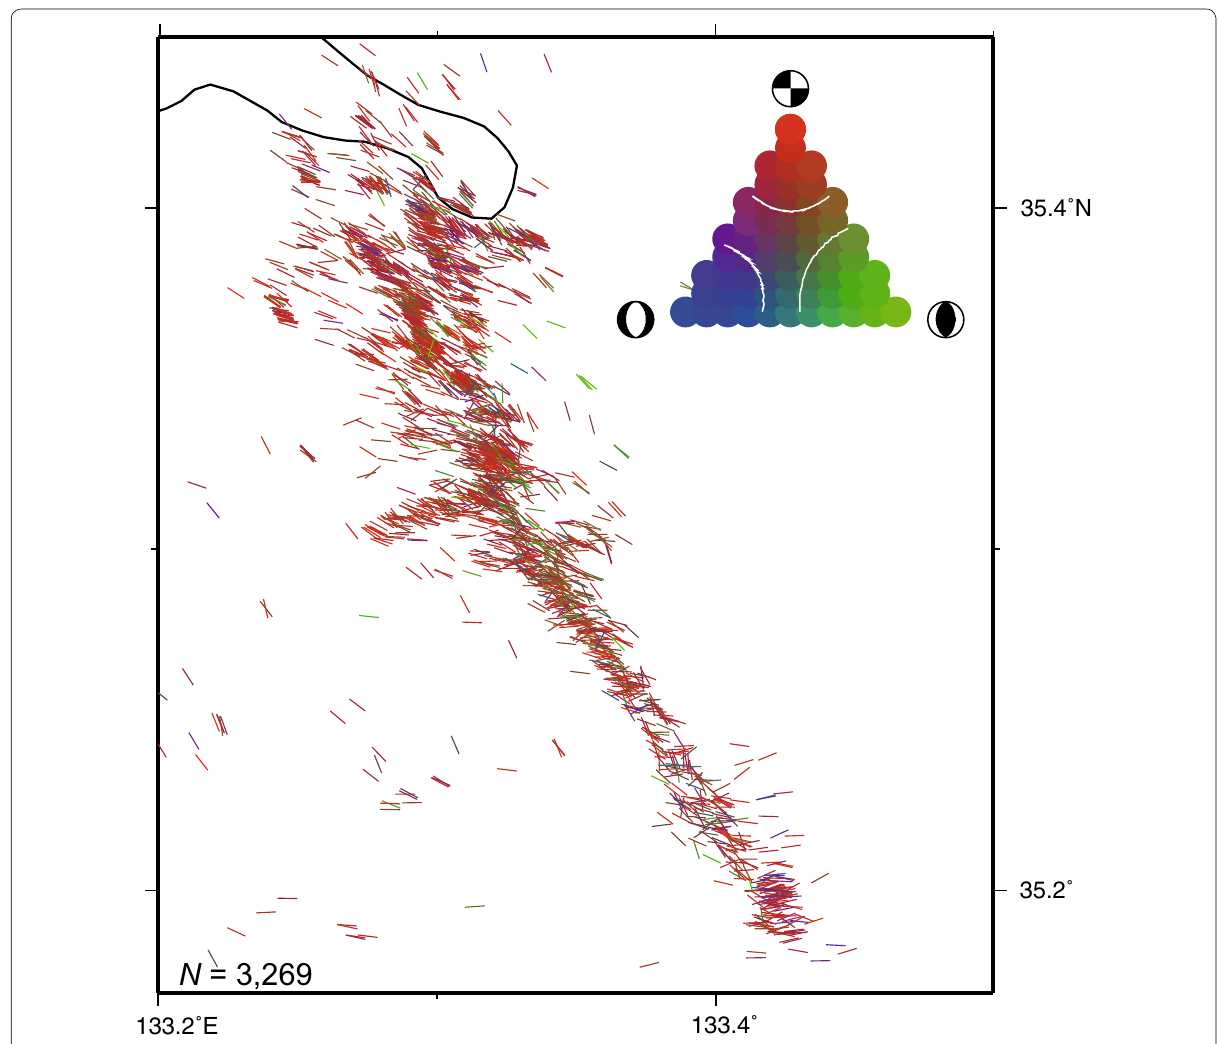
Fig. 3 Spatial distribution of the P-axis azimuths in the focal mechanism solutions. The colors of the P-axes indicate the classification of the focal mechanism type according to Frohlich (2001), as defined by the color palette at top